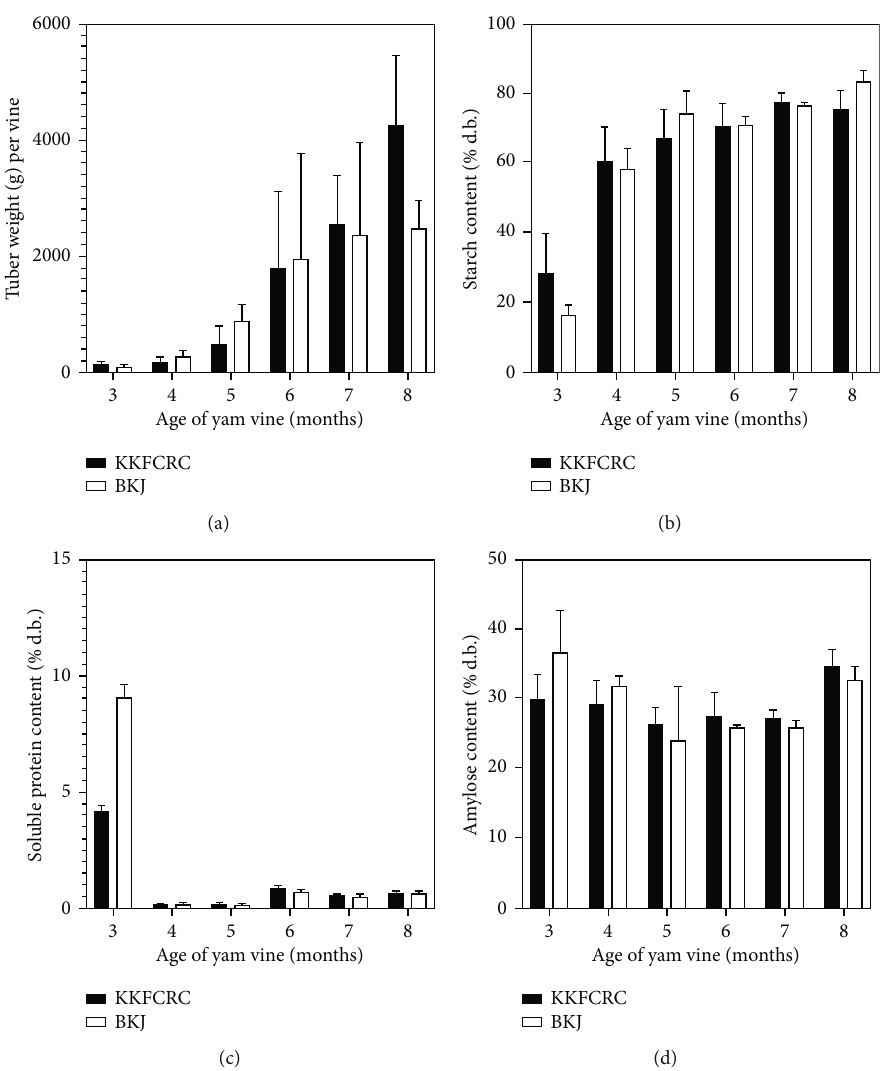
Figure 2: E ff ect of vine age and accession (KKFCRC vs BKJ) on yam tuber qualities: (a) tuber weight, (b) starch, (c) protein content, and (d) amylose content in yam tuber. Bars represent standard